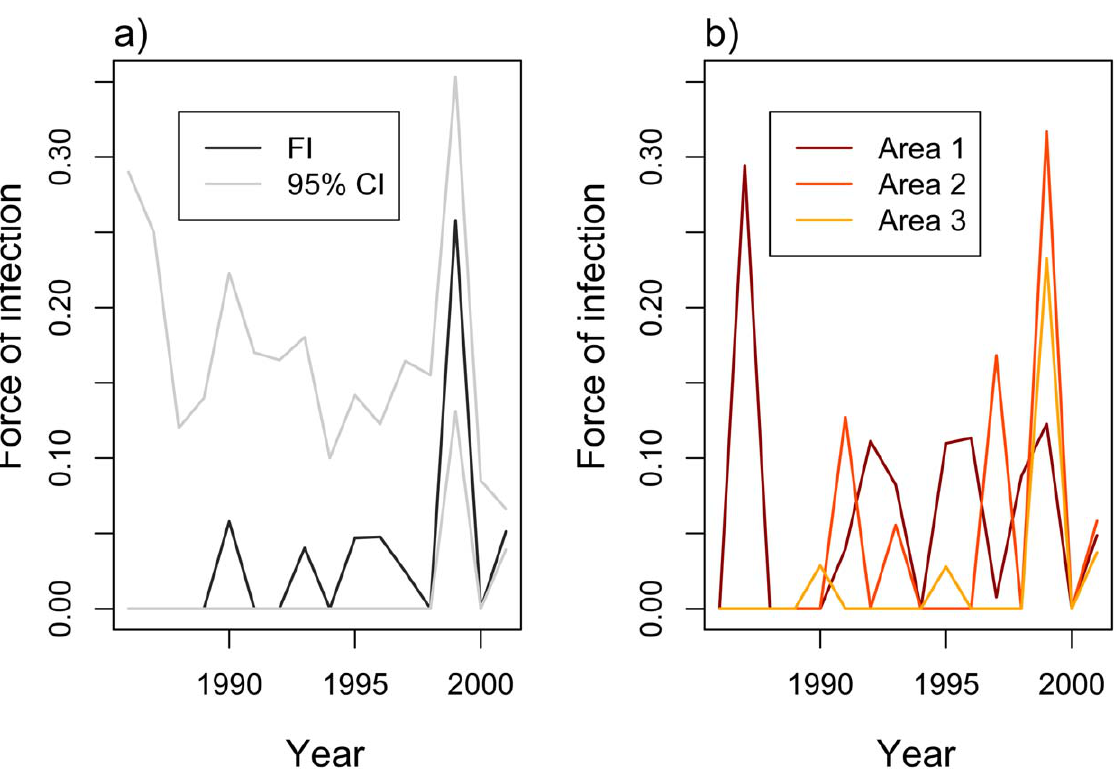
Figure 2. Estimated average time-varying forces of infection. a) Estimated average time-varying forces of infection (FI), with 95% confidence intervals for Recife over the period 1986–2006. b). Estimated time varying-forces of infection for the three sampled neighborhoods over the period 1986–2001.